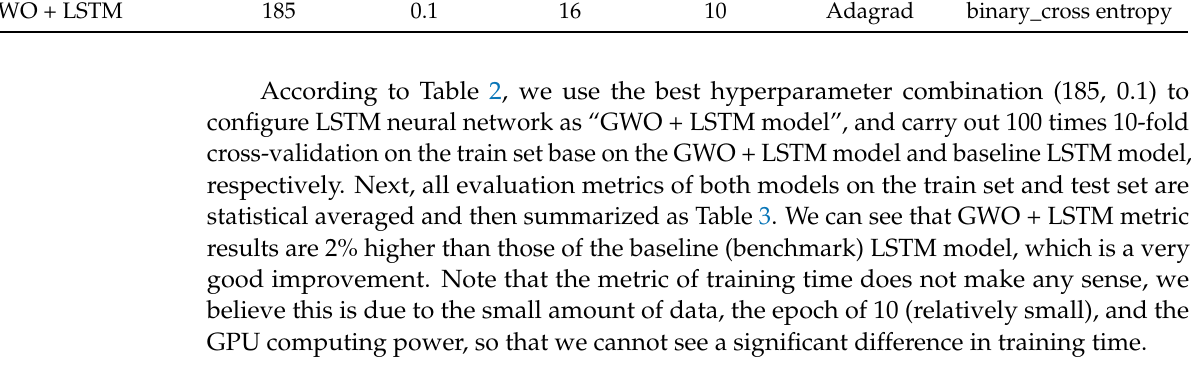
Table 3. Comparison of the average metrics before and after GWO optimized